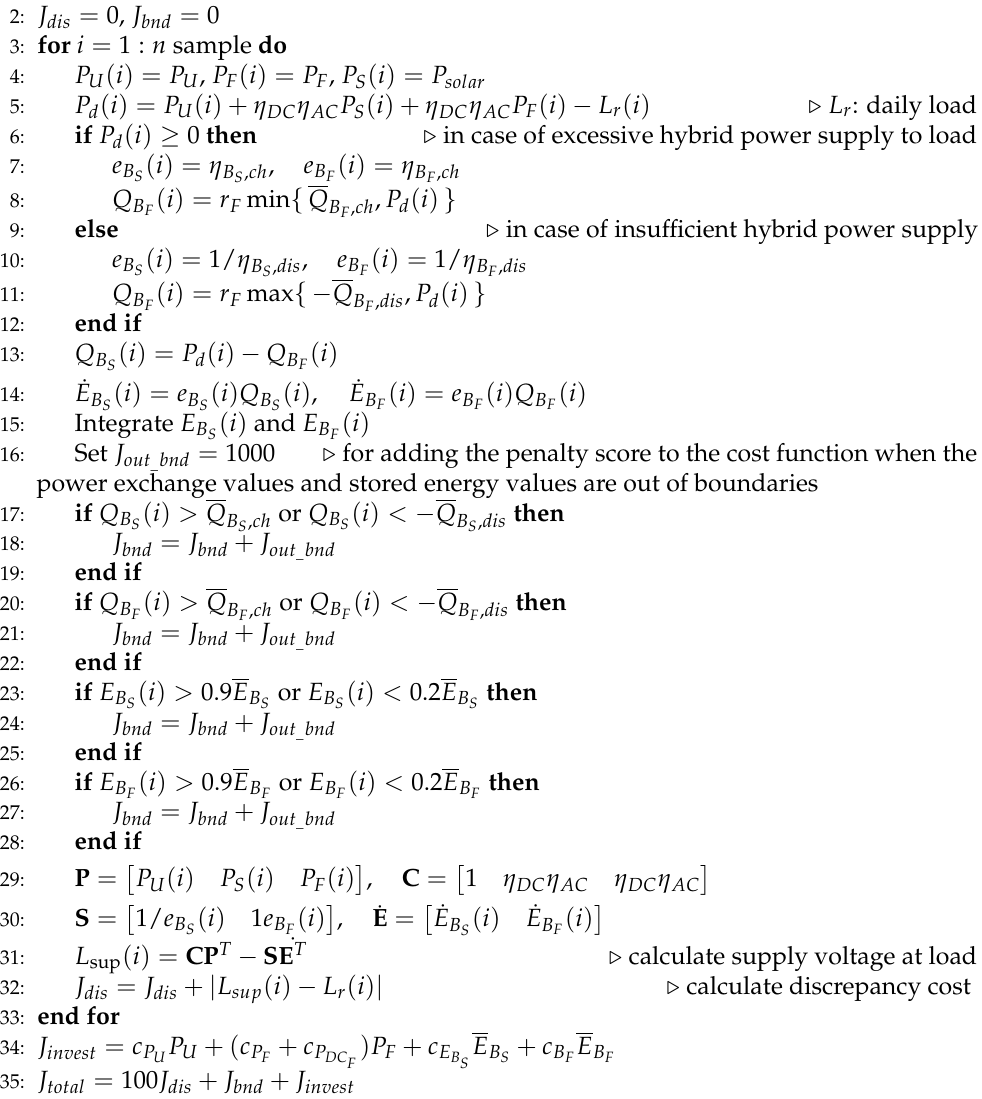
Algorithm 2 Optimization of the current hybrid energy